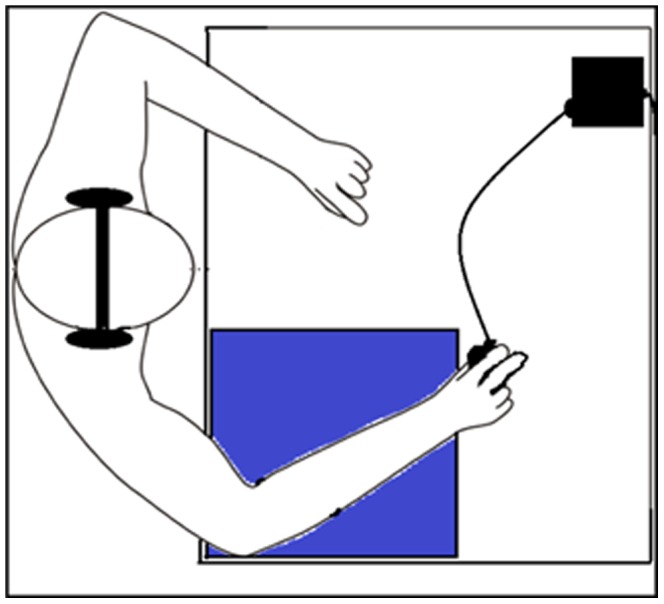
Experimental setting.The participants rested both arms on a padded cushion while holding the grip-force sensor with the right hand in a precision grip (the thumb, index and middle fingers rested on the load cell throughout the experiment).